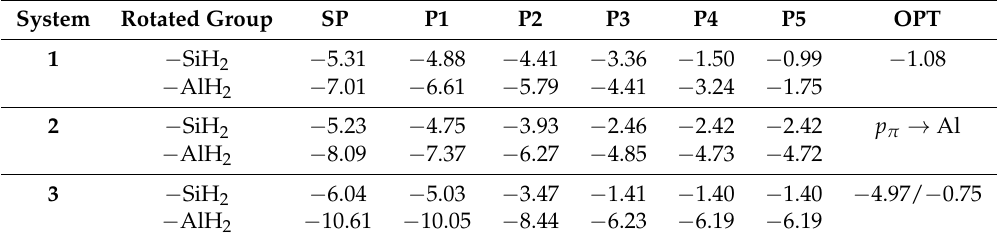
Table 1. Determined (B3LYP/aug-cc-pVTZ) energy values (in kcal/mol) of Si-H · · · Al interactions in 1 c , 2 c and 3 c (see Figure